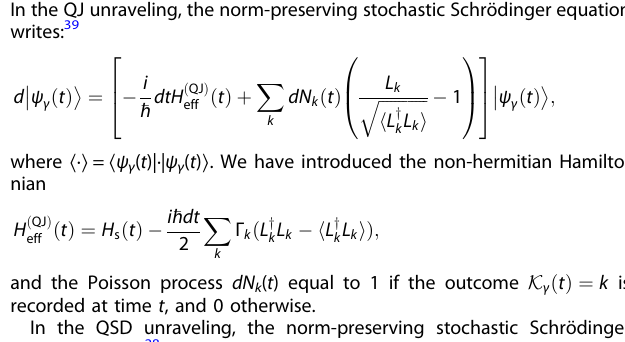
〉 to the target state | γ ( t )